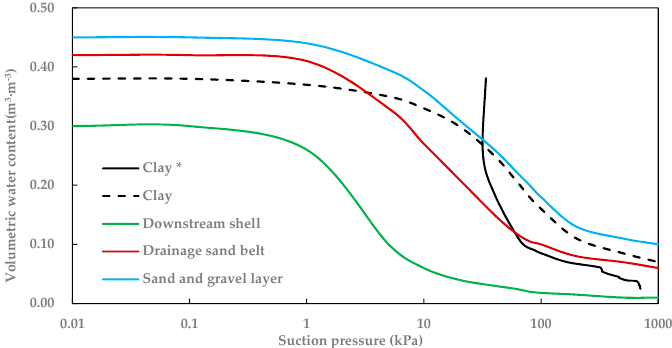
Figure 11. Soil-water characteristic curve of the dam materials (the curve of Clay* is from our experimental data, while the curves of Clay and other materials are from sample functions [24]).